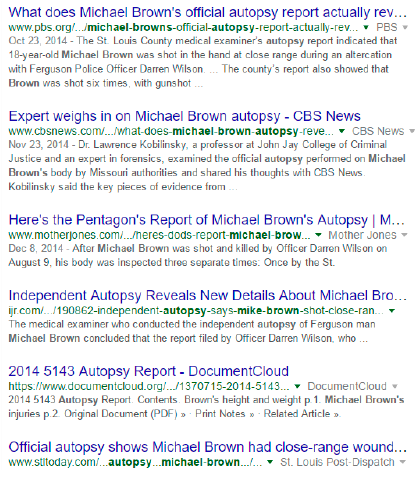
Figure 5. A screencap of results for the search terms “Michael Brown autopsy” already begins to reveal how the expert analysis emphasized in media coverage further reduced Michael Brown to mere